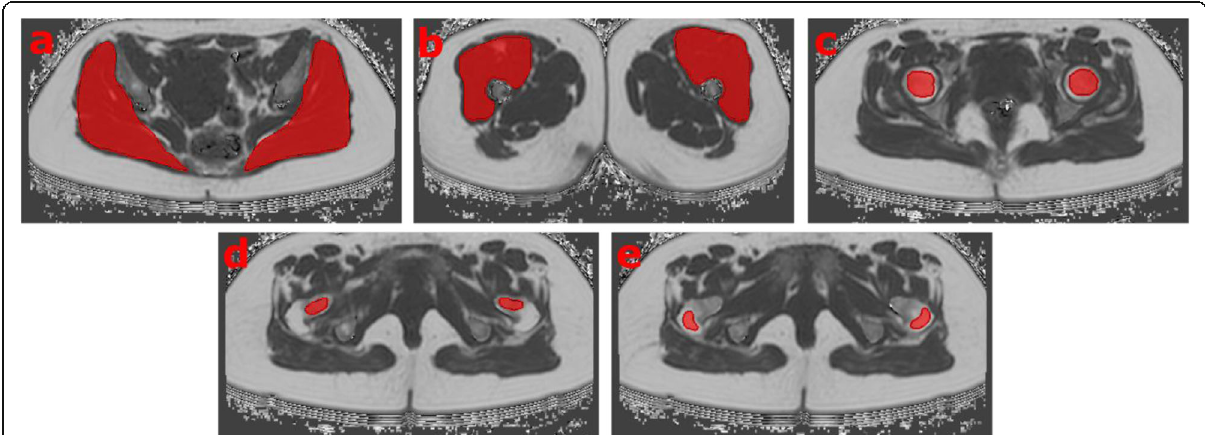
Fig. 2 Representative segmentations (red areas) of the five muscular and osseous compartments, prescribed on axial proton density fat fraction maps of a 39-year-old female subject (body mass index 25.7 kg/m 2 ): gluteal ( a ), quadriceps ( b ), femoral head ( c ), femoral neck ( d ), and greater trochanter ( e )